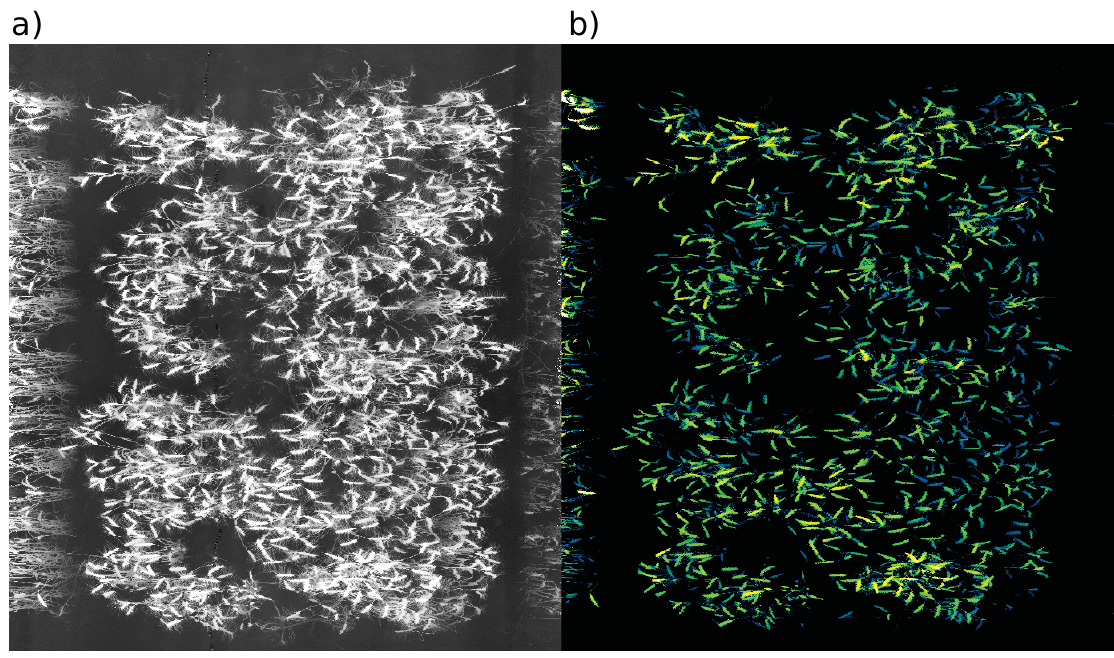
Figure 6. An example of the application of LiDAR for counting spikes in wheat. The LiDAR elevation image ( a ) can be segmented into an image showing only the top fraction of the image, which clearly shows the spikes ( b ). A simple particle count algorithm can be used to count the number of elements per